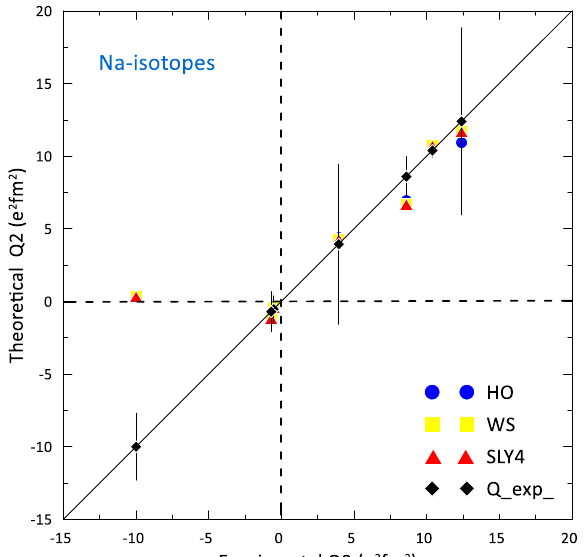
Figure 7: The calculated electric quadrupole moments Q2 (e 2 fm 2 ) vs the experimental data [16, 17] for Na-isotopes using different single-particle potentials; HO, WS, 89and SLy4.